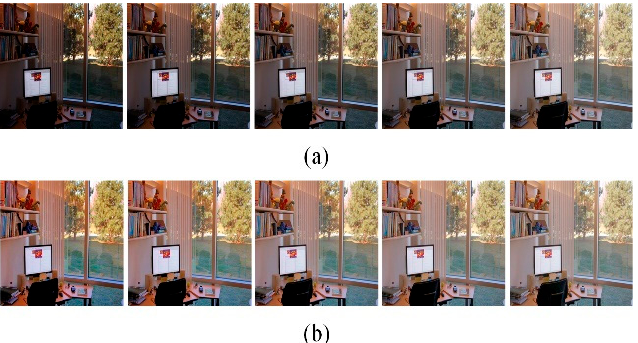
Figure 13. Office. ( a ) Input different global illumination image sequences. ( b ) Output almost the same global illumination image sequence.